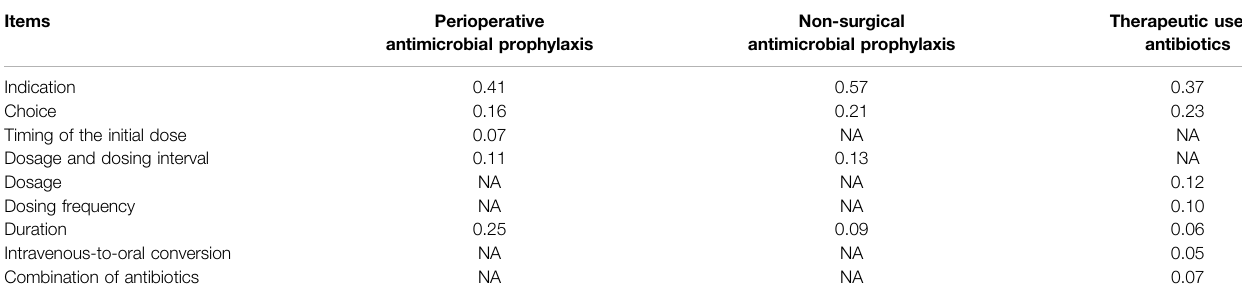
TABLE 4 | The scoring system involving weights of different items. Items Perioperative